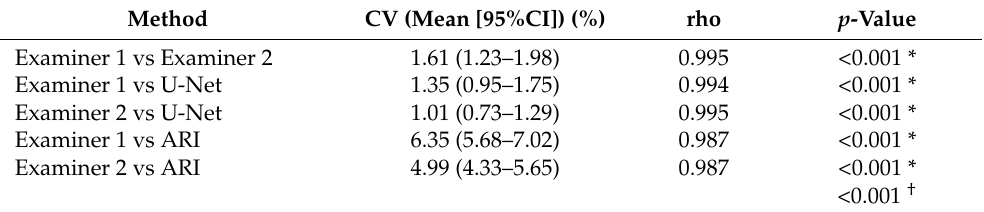
Table 2. The coefficient of variation and Friedman test results for each extraction method, and correlation of the FAZ area obtained by each extraction method.